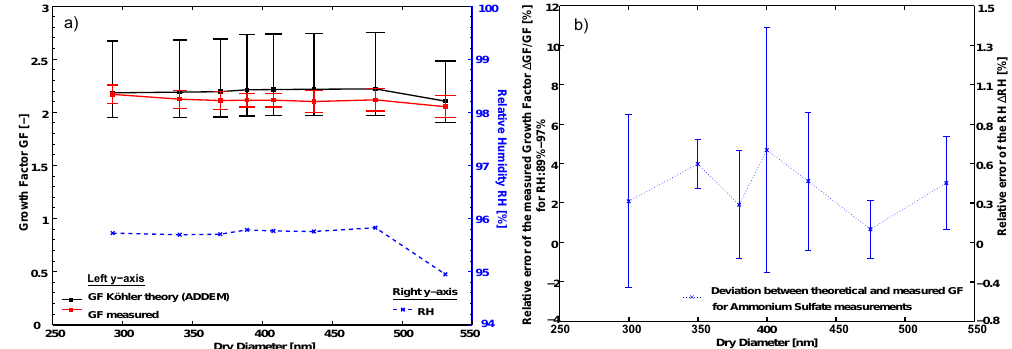
Figure 11. (a) Shows a typical example of the hygroscopic growth factors (red markers) measured by the WHOPS for pure ammonium sulfate particles of different dry sizes along with the relevant relative humidity (blue markers) simultaneously measured in the WHOPS. In (a) the error bars around the measured GFs indicate the accuracy of 6–10% as described in Sect. 3.1.3. The theoretical growth factors (ADDEM Model; Topping et al., 2005) corresponding to the measured RH are shown in black, where the error bars indicate the propagated uncertainty corresponding to an experimental accuracy of the measured relative humidity of ∼ ± 2% (absolute). The markers and error bars shown in (b) indicate the statistics (mean and standard deviation from eight independent experiments) of the relative difference between measured and theoretical growth factor of ammonium sulfate particles at RHs between 89 and 97% for different dry sizes. The right y axis shows the hypothetical RH bias at RH = 95%, which would explain the corresponding observed GF bias shown on the left y